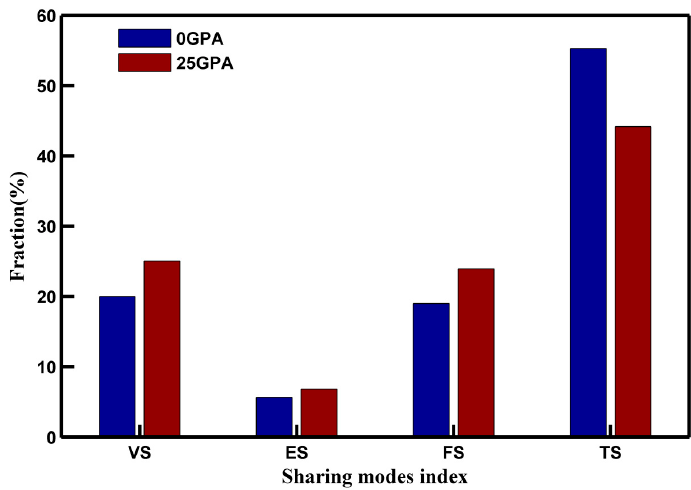
Figure 9. Sharing frequencies for each cluster.